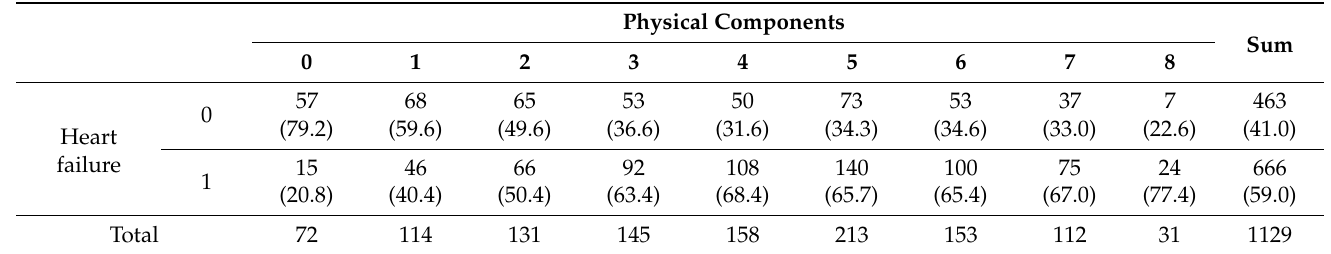
Table 4. Distribution of subjects by aggregate physical component index value and heart failure occurrence. Numbers in parentheses denote column-wise